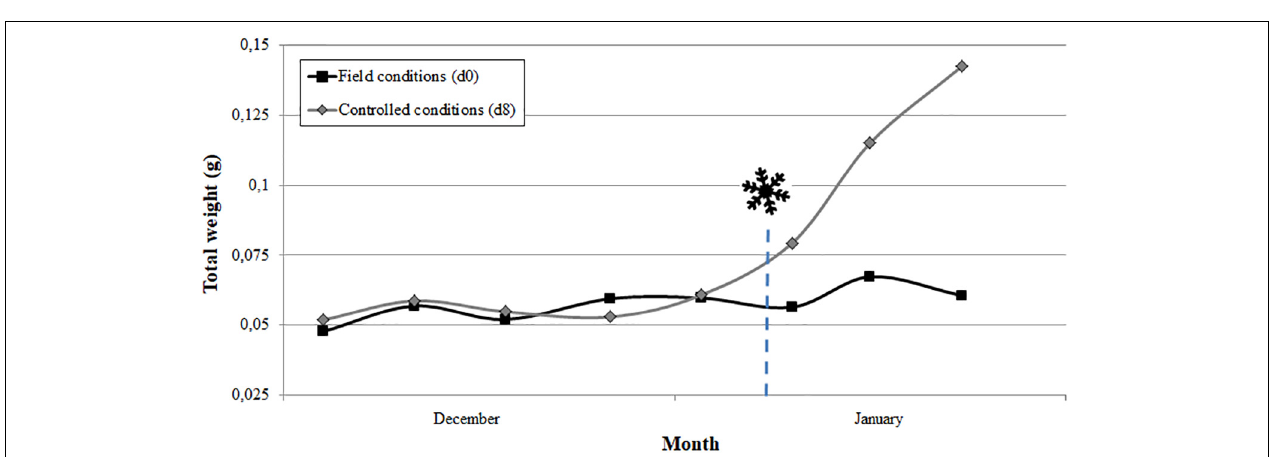
FIGURE 1 | Mean daily chill portion accumulation per year for the period 1998–2021 at Zaragoza (Spain).